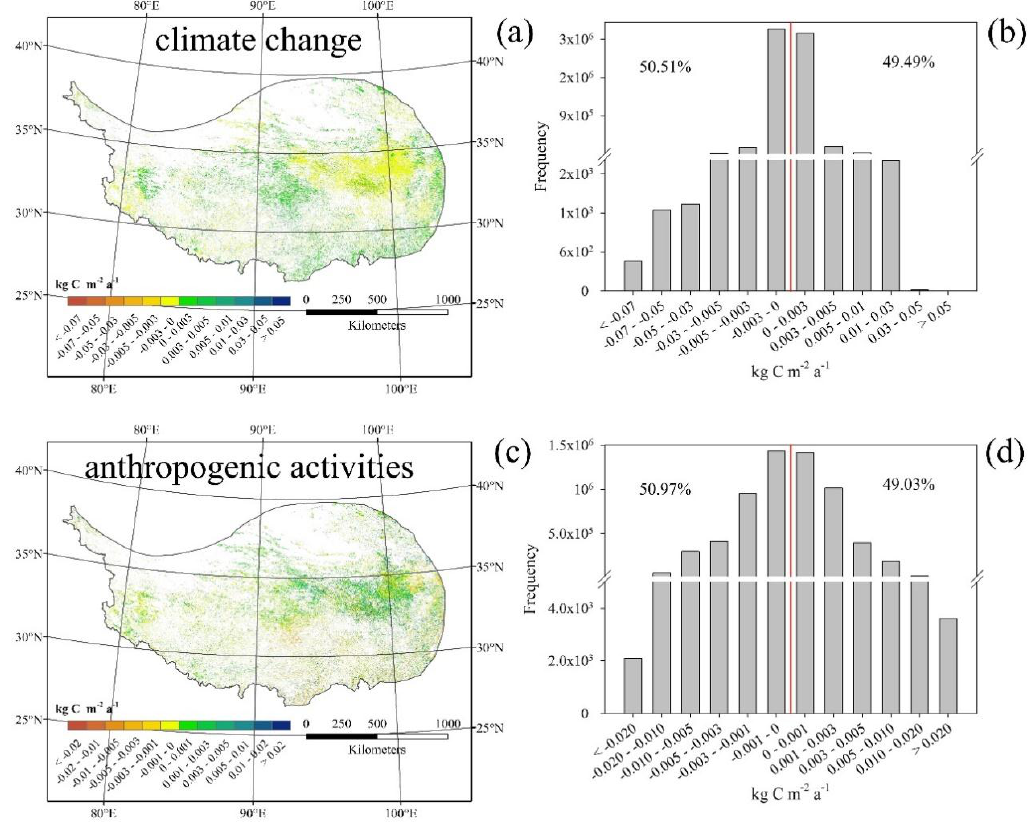
Figure 6. Trends of NPP under the isolated impact of ( a ) climate change and ( b ) anthropogenic activities; ( c , d ) show the corresponding frequency distributions of impacts of climate change and human activities, respectively.